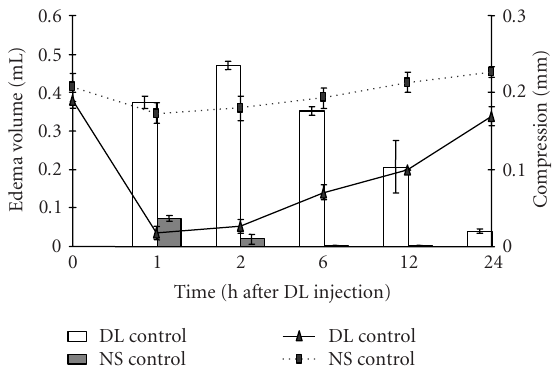
Figure 1. Time course for DL-induced edema formation and extent of compression required to elicit pain in rat paw. Aque- ous solution of DL of C procera (0 . 1mL of 1% solution) and NS (0 . 1mL) were injected into the subplantar surface of the rat paw and edema volume and compression were measured at 1, 2, 6, 12, and 24 hours ( n = 6). Bars indicate edema volume and lines indicate compression to elicit